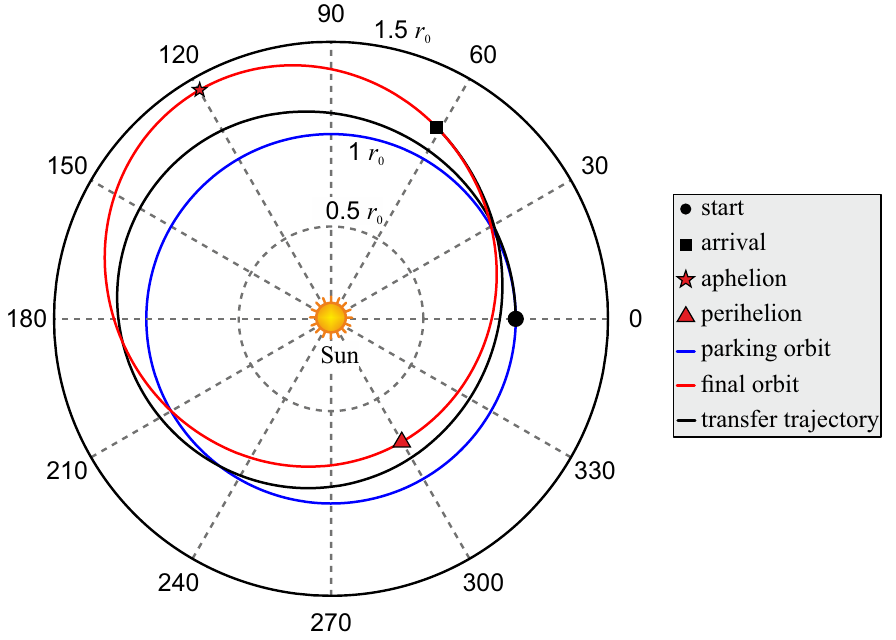
Figure 8. Optimal transfer trajectory when e f = 0.3 and β =